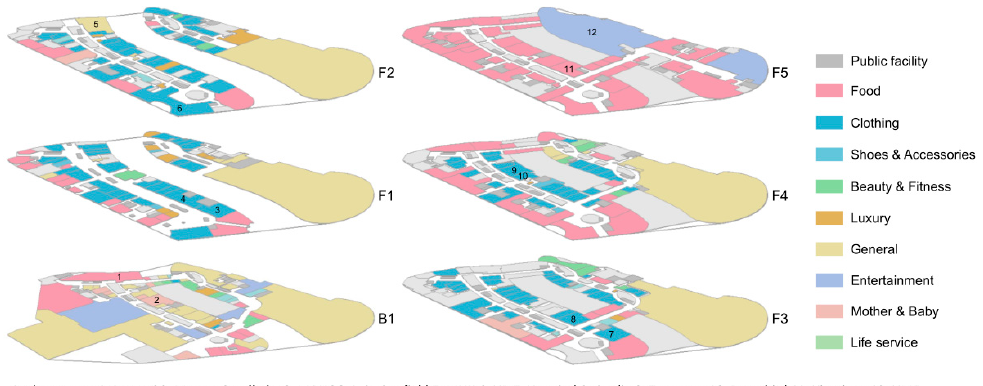
Figure 3. Store classes and layout of LH (F1-F5 means Floor 1 to 5 and B1 means Basement level 1).